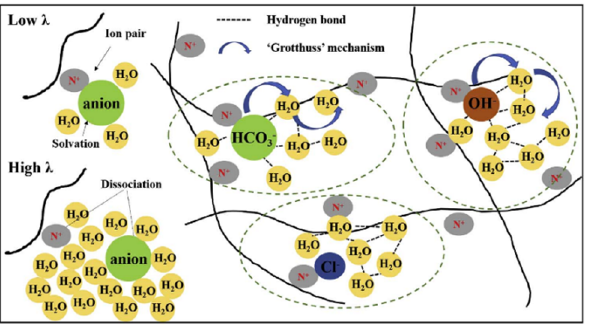
Figure 39. Schematic illustration of ion and water transport in Tokuyama A201. Reprinted with permission from Ref. [78]. Copyright © 2022 Published by Elsevier B.V.